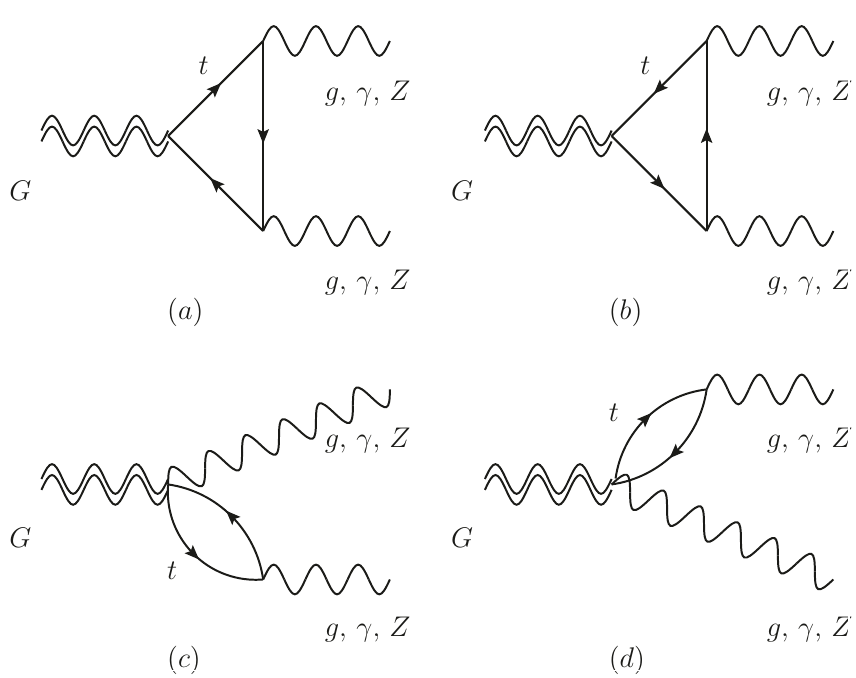
Figure 1 . Feynman diagrams for the one-loop top-quark contributions to the Ggg , G(cid:13)(cid:13) , G(cid:13)Z , and GZZ